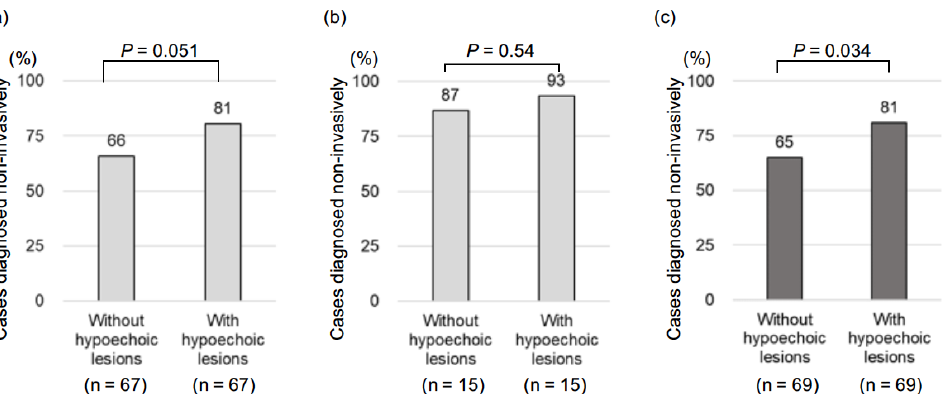
vasively diagnosed in 66% and 81% of the 67 cases without and with the use of multiple hypoechoic lesions in SGs, respectively ( p = 0.051). A noninvasive diagnosis of IgG4-SC was established in 87% and 93% of 15 cases without and with the use of multiple hy- poechoic lesions in SGs, respectively ( p = 0.540). A noninvasive diagnosis was established in all IgG4-related pancreaticobiliary diseases (combined AIP and IgG4-SC) in 65% and 81% of 69 cases without and with the use of multiple hypoechoic lesions of the SGs, re- spectively ( p = 0.043).